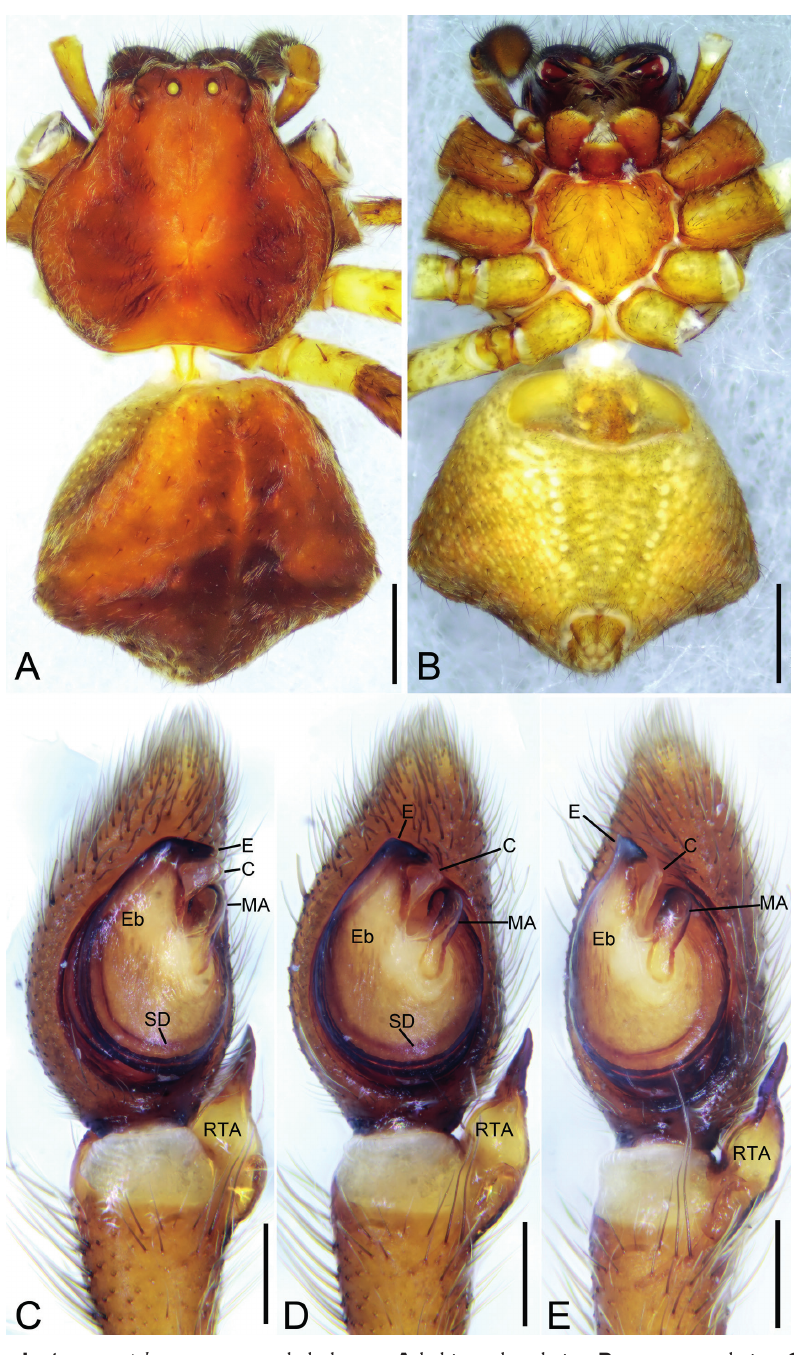
Figure 1. Angaeus xieluae sp. nov., male holotype. A habitus, dorsal view B same, ventral view C palp, prolateral view D same, ventral view E same, retrolateral view. Abbreviations: C – conductor, E – embo- lus, Eb – base of the embolus, MA – median apophysis, RTA – retrolateral tibial apophysis, SD – sperm duct. Scale bars: 0.5 mm ( A, B ), 0.1 mm ( C–E